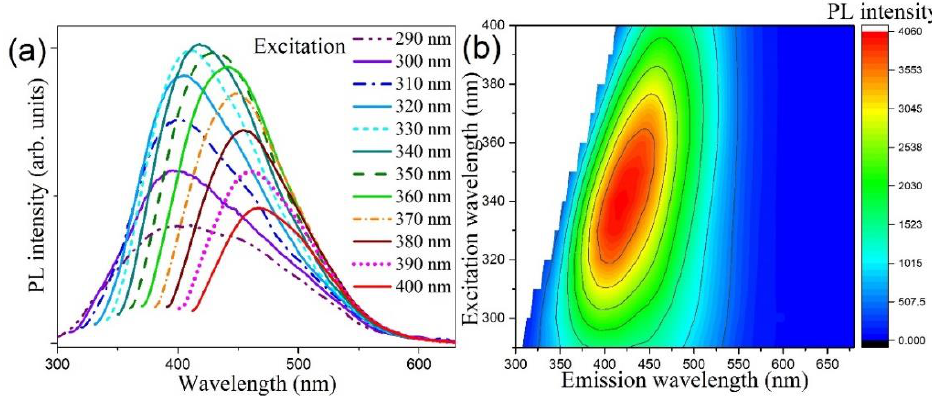
Figure 6. ( a ) Excitation-wavelength dependent photoluminescence (PL) spectra of colloidal MoSe 2 QDs at room temperature. ( b ) The 2D contour map acquired from the PL spectra. The characteristic contour is due to the pronounced quantum confinement effect.